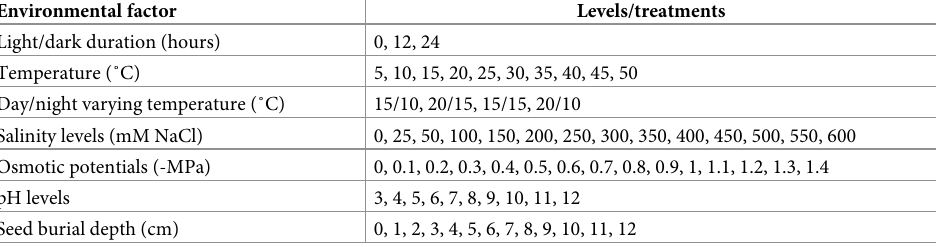
Table 3. The details of environmental cues and their levels used to study the seed germination biology of Conyza stricta